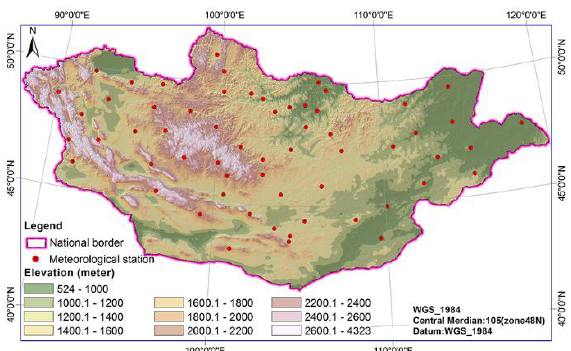
Figure 1. Mongolian topography and location of meteorological stations (n = 60) for which reference air temperature information from weather stations was available. Map of digital elevation model (DEM) was derived from the Shuttle Radar Topography Mission (SRTM-DEM) with a resolution of 90 m.